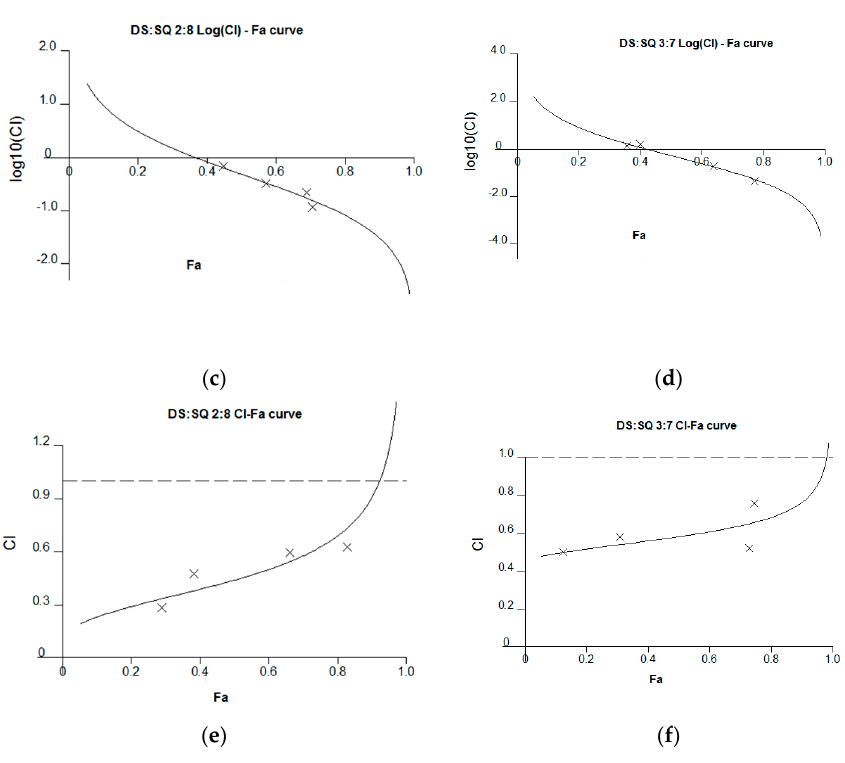
Figure 4. Synergism analysis of DS-SQ 2:8 and 3:7 on restoring cell proliferation, wound scratch and tube formation activities against Hcy and Ado in EAhy 926 cells. CI-Fa curves for DS-SQ 2:8 ( a ) and DS-SQ 3:7; ( b ) on cell proliferation. Log (CI)-Fa curves for DS-SQ 2:8; ( c ) and DS-SQ 3:7; ( d ) on wound healing. CI-Fa curves for DS-SQ 2:8; ( e ) and DS-SQ 3:7; ( f ) on tube formation. CI values were plotted as a function of cell wound healing activity (Fa) by ‘Calcusyn’ software. Solid line is the reference line, where Log(CI) value equals 0 (CI = 1). The curve with spots represents CI values at different Fa. Isobolograms of DS-SQ 2:8 (E) and DS-SQ 3:7 (F) at different effect levels (50%, 75% and 90%).